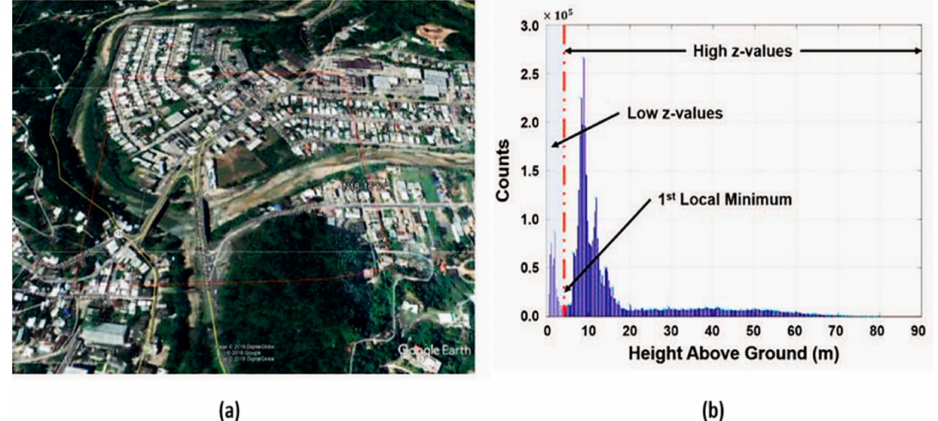
Figure 8. ( a ) Google Earth image of Rio Vivi in Utuado PR. ( b ) Histogram of Z-values. Data below the 1st local minimum removes waterways. Waterways have lower z-values than roads.